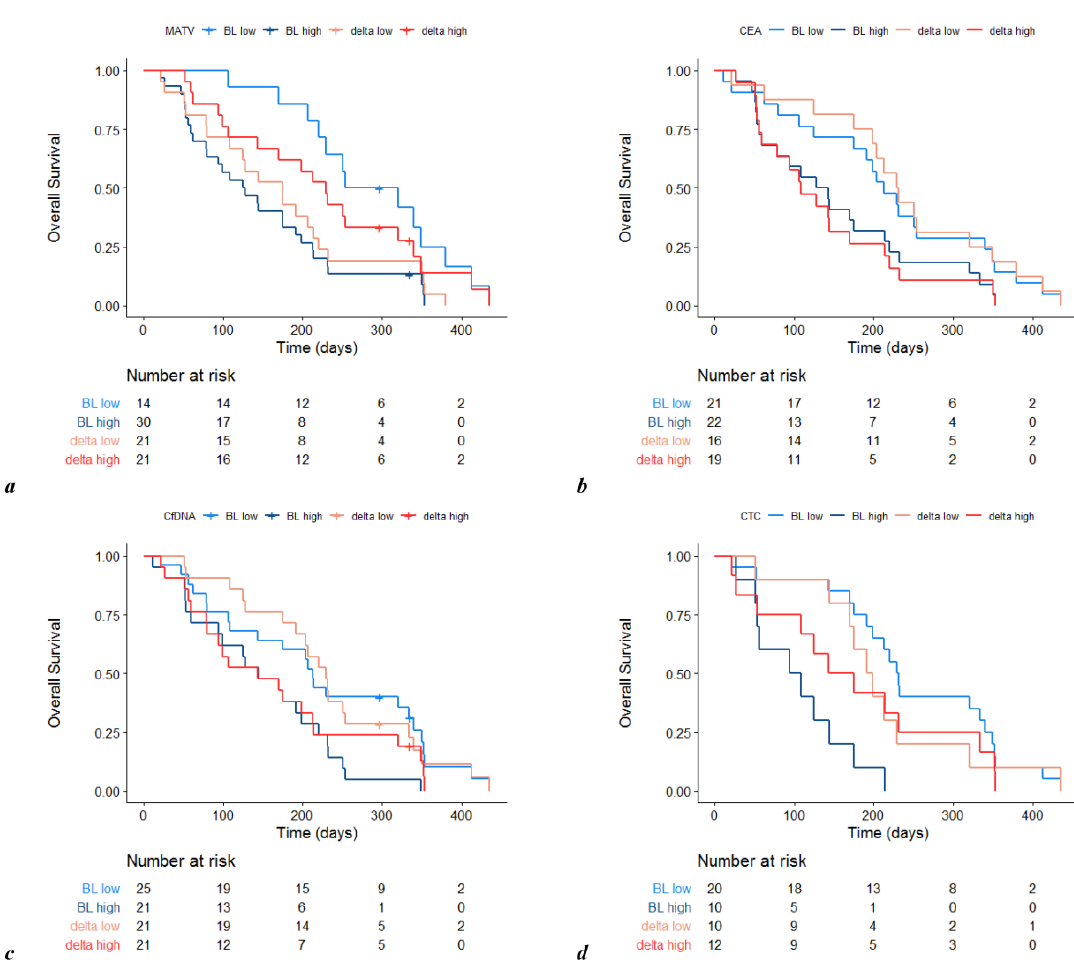
Figure 2. Overall survival by baseline (BL) and early 2-week change (delta) of WB-MATV ( a ), CEA ( b ), cfDNA ( c ) and CTC ( d ). Abbreviations: WB-MATV, whole body metabolically active tumor volume; CEA, carcinoembryonic antigen; cfDNA, circulating-free DNA; CTC, circulating tumor cell. Prognostic value of liquid biomarkers.